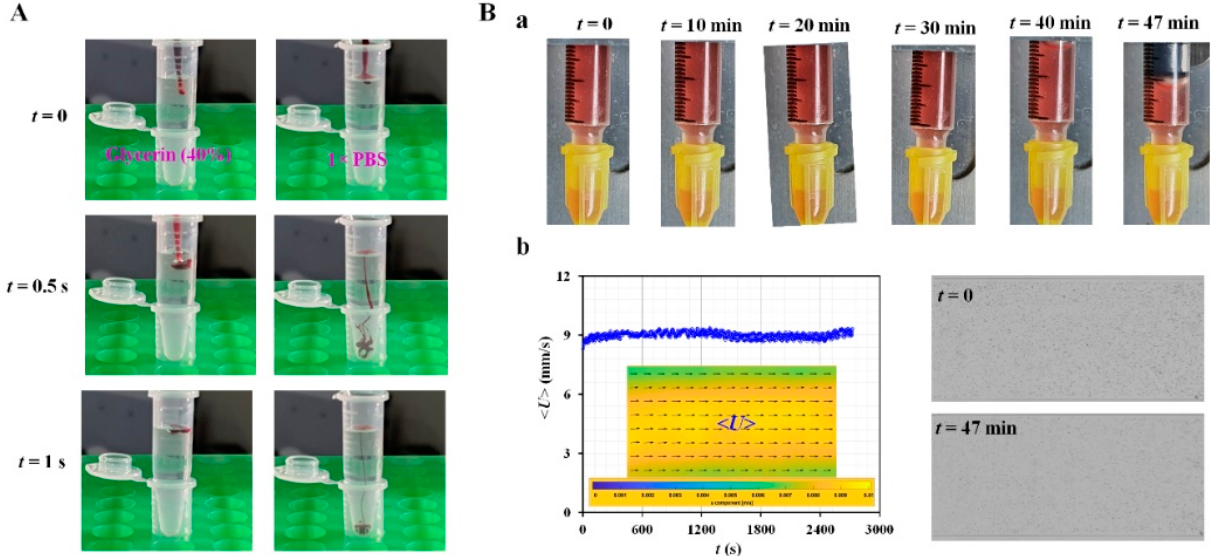
Figure A2. Validation of RBC sedimentation in reference fluid. ( A ) Sedimentation test of RBCs suspended in two different fluids (i.e., glycerin solution (40%) and 1× PBS) with an elapse of time ( t ) ( t = 0, 0.5 and 1 s). ( B ) Validation of RBC sedimentation in glycerin solution (40%). ( a ) Snapshots for evaluating RBC sedimentation in a driving syringe over time ( t ) ( t = 0, 10, 20, 30, 40, and 47 min). ( b ) Temporal variation of averaged velocity (<U>) over time. Inset shows the velocity fields of the reference fluid. Right panel shows microscopic images captured at an initial time ( t = 0) and final time ( t = 47 min).